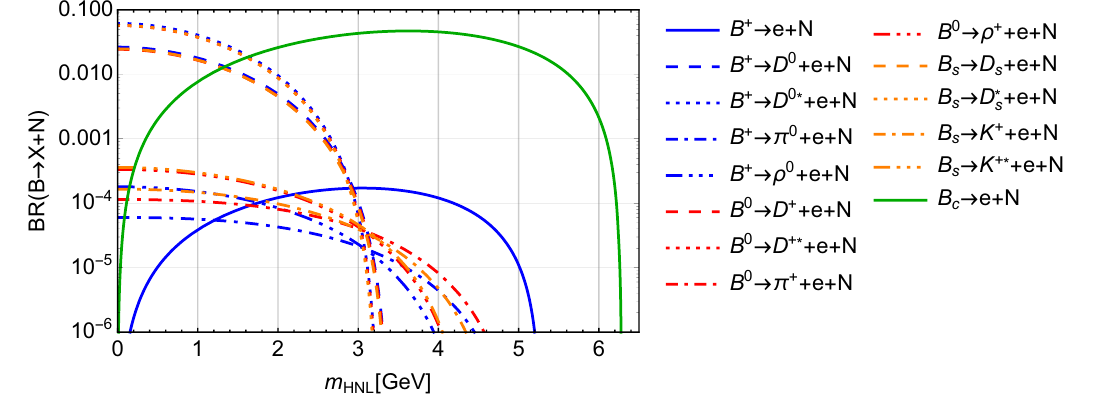
Figure 5 . Dominant branching ratios of HNL production from di(cid:11)erent beauty mesons. For charged mesons two-body leptonic decays are shown, while for the neutral mesons decays are nec- essarily semi-leptonic. For these plots we take U e = 1, U (cid:22) = U (cid:28) = 0. suppression the branching ratio of B + N + ‘ + is signi(cid:12)cantly smaller than that !